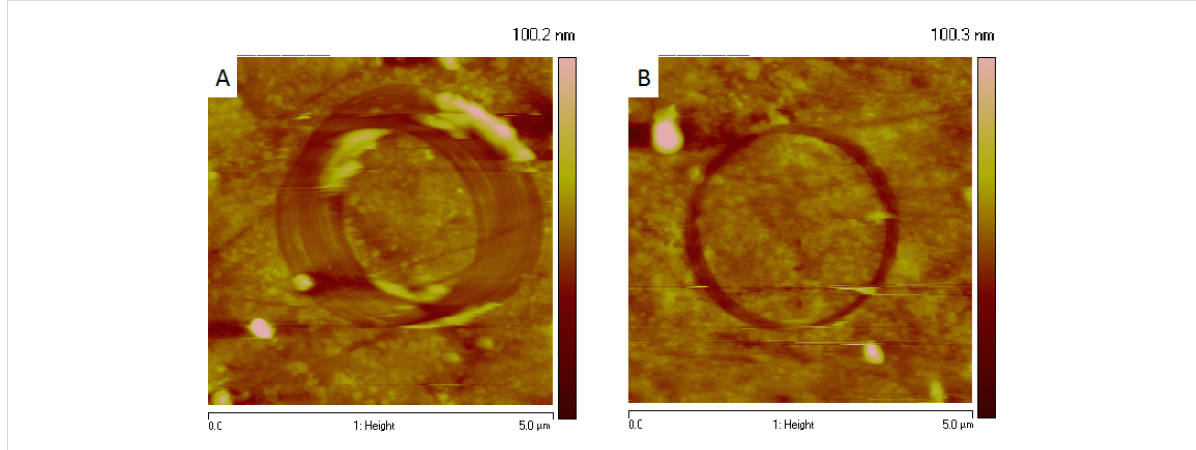
Figure 2: Atomic force microscopy (AFM) contact mode topographic images of wear tracks resulting from wear experiments on copper-based com- posites (the counter-body is a silicon nitride probe) at a constant normal load of 180 nN with constant sliding distance and sliding velocities of (A) 100 µm/s and (B) 1 mm/s. To maintain a constant sliding distance, the wear duration is 100 min for the experiment in (A) and 10 min for the exper- iment in (B). It is clearly demonstrated that a long wear time results in a large and low-depth wear track due to the